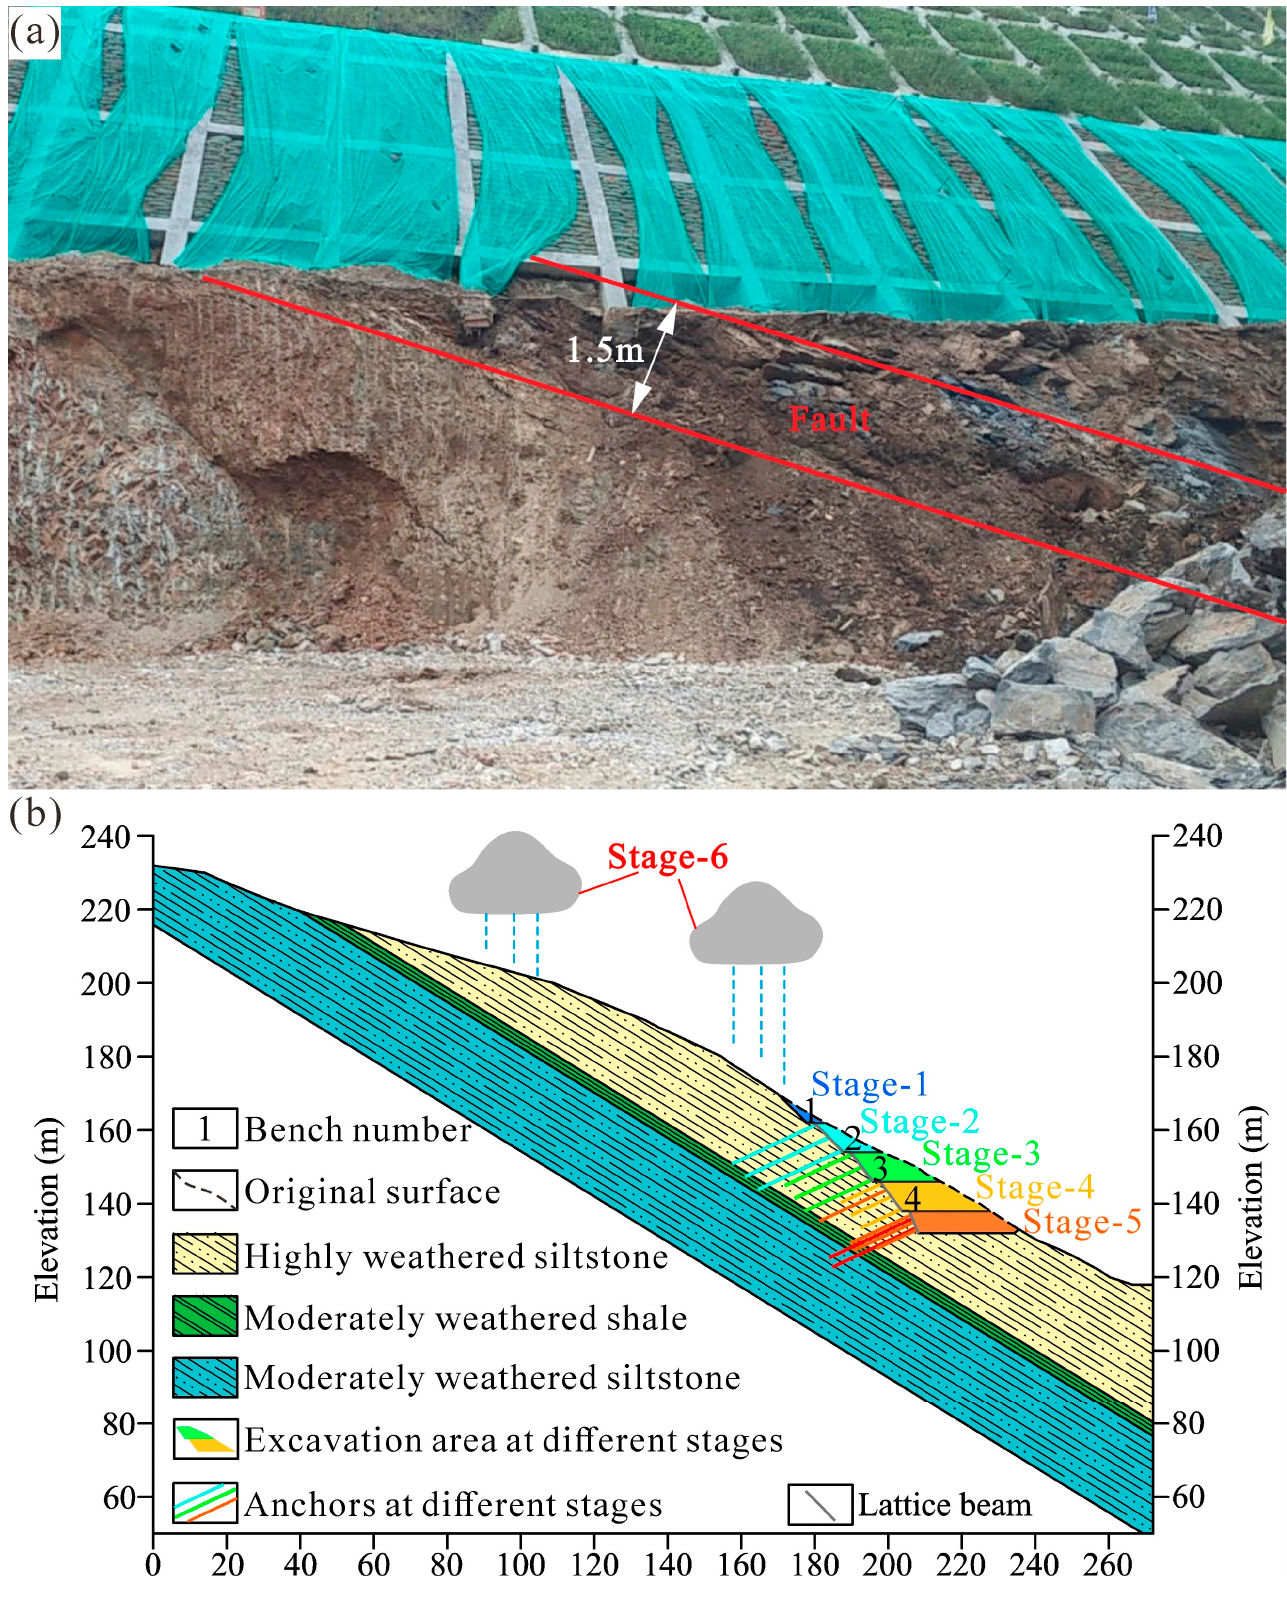
Figure 3. Fault characteristics of the Anling landslide and process of the slope excavation. ( a ) The photo of the fault. ( b ) The different stages of slope excavation.